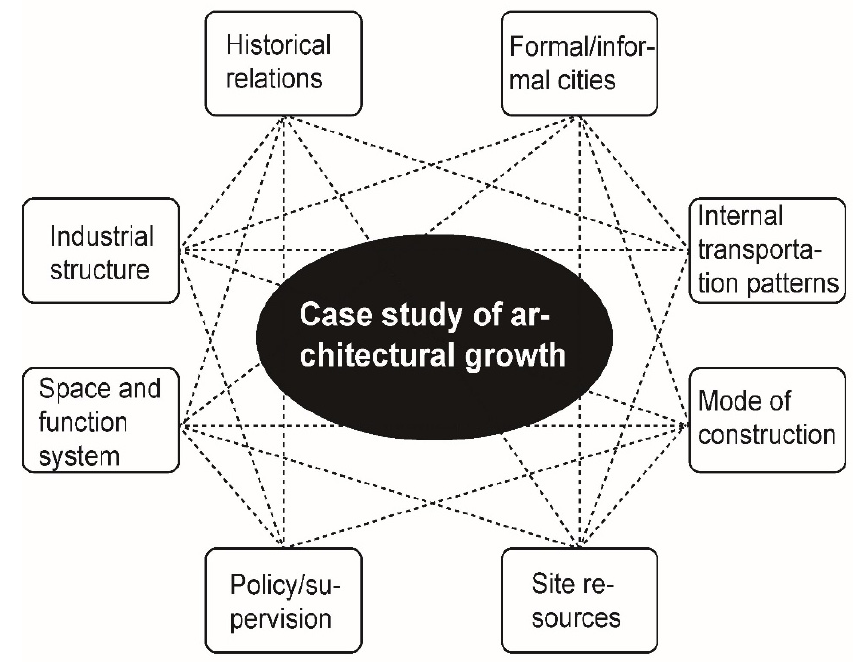
Figure 1. Case study framework of architectural growth (Source: